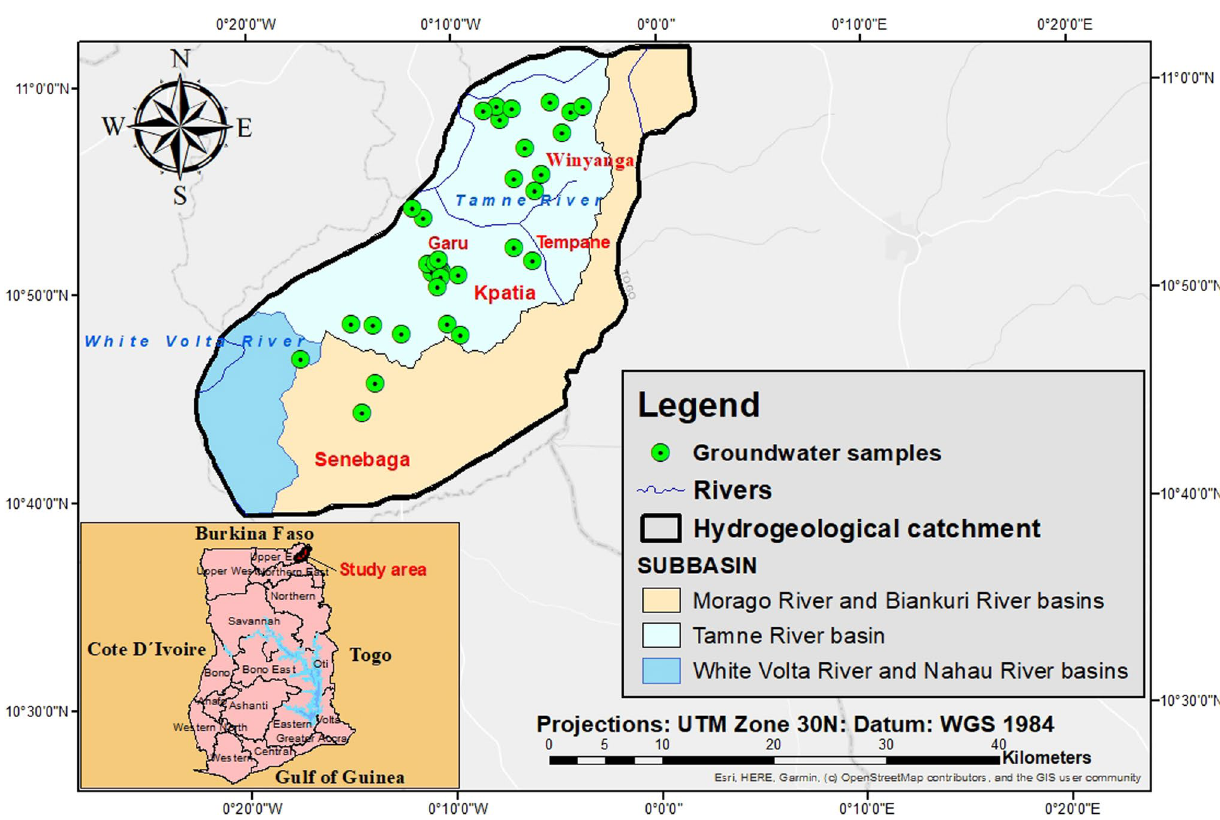
Fig. 1 Location map of the study